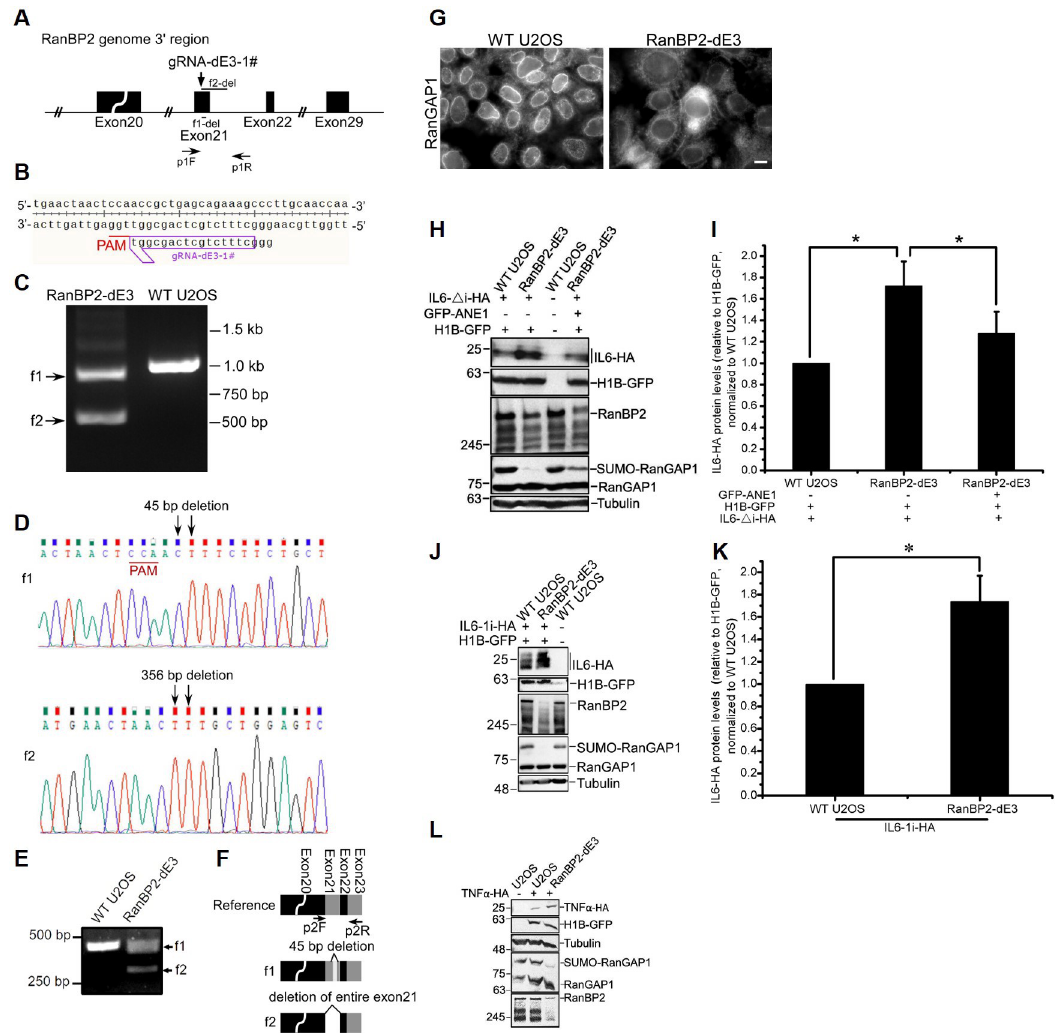
Fig 2. The SUMO E3-ligase domain of RanBP2 is required for the repression of IL6 in U2OS cells. The SUMO E3-ligase domain of RanBP2 was targeted by CRISPR/Cas9 in U2OS cells. (A) A schematic diagram of the region of the RanBP2 gene targeted by CRISPR/Cas9 loaded with the guide RNA, “gRNA-dE3-1#”, whose sequence is shown in (B). Also indicated are the PCR amplification primers “p1F” and “p1R”, and the regions deleted “f1-del” and “f2-del” in each RanBP2 allele present in the cell clone “RanBP2-dE3”. (C) PCR amplification, using p1F and p1R primers, of the genomic region targeted by gRNA-dE3-1#. Note that the reaction from the RanBP2-dE3 cell clone lysates produced two amplicons (“f1” and “f2”), which were both smaller than the amplicon produced from unmodified wildtype U2OS cells (“WT U2OS”). (D) Sequencing of the two PCR products (f1 and f2) in (C). Note that the length of the deletion in each RanBP2 gene allele are indicated. (E) cDNA amplification, using p2F and p2R primers indicated in (F), of RanBP2 mRNA. Note that the reactions with RanBP2-dE3 cell lysates produced two amplicons, corresponding to the two mRNA forms from f1 and f2 gene copies in (C-D). (F) Schematic of the modified regions in the RanBP2 mRNAs. Also indicated are the PCR primers “p2F”and “p2R” for cDNA amplification, and the regions deleted in mRNAs produced from each RanBP2 allele in RanBP2-dE3 cells. (G) Unmodified and RanBP2-dE3 U2OS cells were fixed, immunostained using anti- RanGAP1 antibody and imaged by epifluorescence microscopy. Scale bar = 10 μ m. (H-I) Various U2OS cell lines (unmodified, RanBP2-dE3 and RanBP2-dE3 that stably express GFP-tagged RanBP2 which contains 3 ANE1-associated mutations, “GFP-ANE1”) were transfected with plasmids containing an intronless version of IL6-HA ( IL6- Δ i-HA ) and histone 1B-GFP ( H1B-GFP ). Cell lysates were collected 24 h post-transfection and separated by SDS-PAGE. Proteins were detected with by immunoblot with antibodies against HA, GFP, RanBP2, RanGAP1 and α -tubulin. Note that H1B-GFP was used as a control for transfection and general mRNA translation while α -tubulin was used as a loading control. Also note that RanBP2-dE3 cells had lower expression of RanBP2 and lacked sumoylated-RanGAP1. This sumoylation pattern was re-established by the expression of GFP-ANE1. The level of GFP-ANE1 was less than the level of RanBP2 present in unmodified U2OS cells (H). IL6-HA and H1B-GFP protein levels were quantified using densitometry analysis and the ratio of IL6-HA/H1B-GFP was normalized to unmodified U2OS cells, with each bar representing the average of three independent experiments ± SEM (I). (J-K) Same as (H-I), except that an intron-containing IL6-HA construct ( IL6-1i-HA ) was used. (L) As in (H), except that TNF- α -HA was transfected. � P = 0.01–0.05 (Student’s t